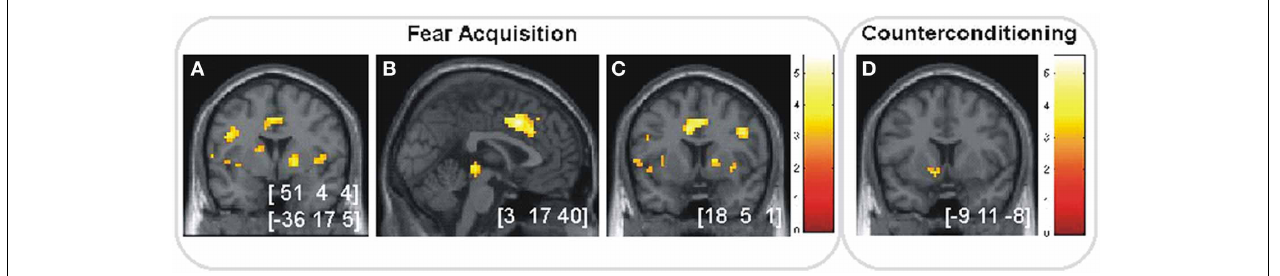
FIGURE 5 | Anticipation of fear and reward. (A–C) Significant activations ( p < 0 . 05, SVC) in the fear acquisition phase for CS + vs. CS − in (A) bilateral insular cortex, (B) right dACC and (C) right striatum. (D) Significant activation ( p < 0 . 05, SVC) in the counterconditioning phase for